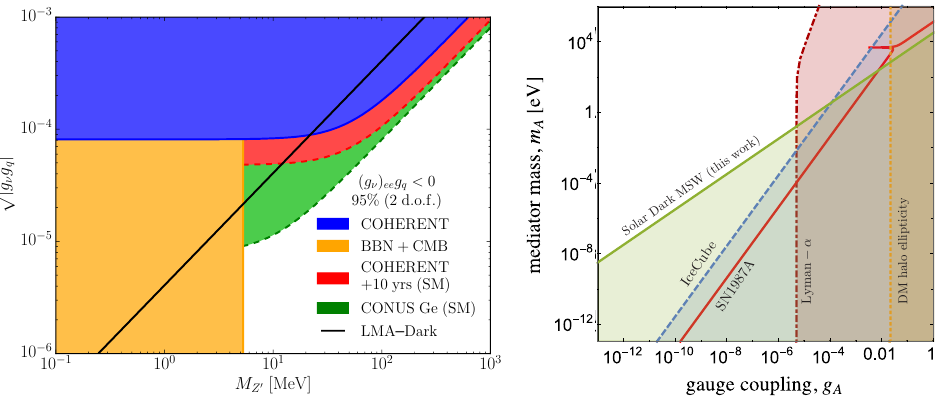
Figure 14.1: Light mediator NSI ( left panel ) is still large enough to account for LMA- Dark, but only in a narrow range of masses [ 21 ] . Large matter effects ( right panel ) can come about in models of dark matter-neutrino interactions [ 295 ]